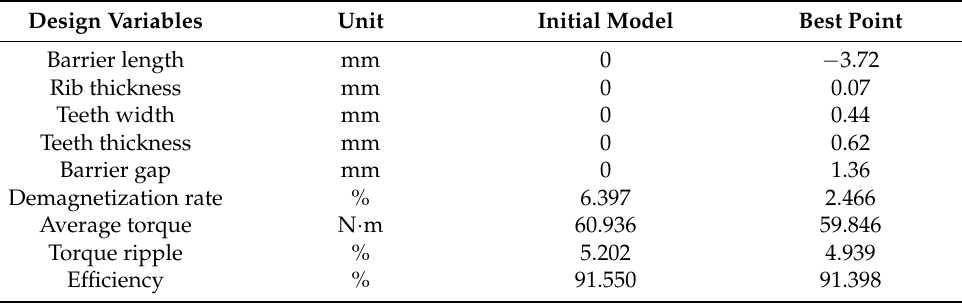
Table 3. Comparison results between the initial model and the best experimental